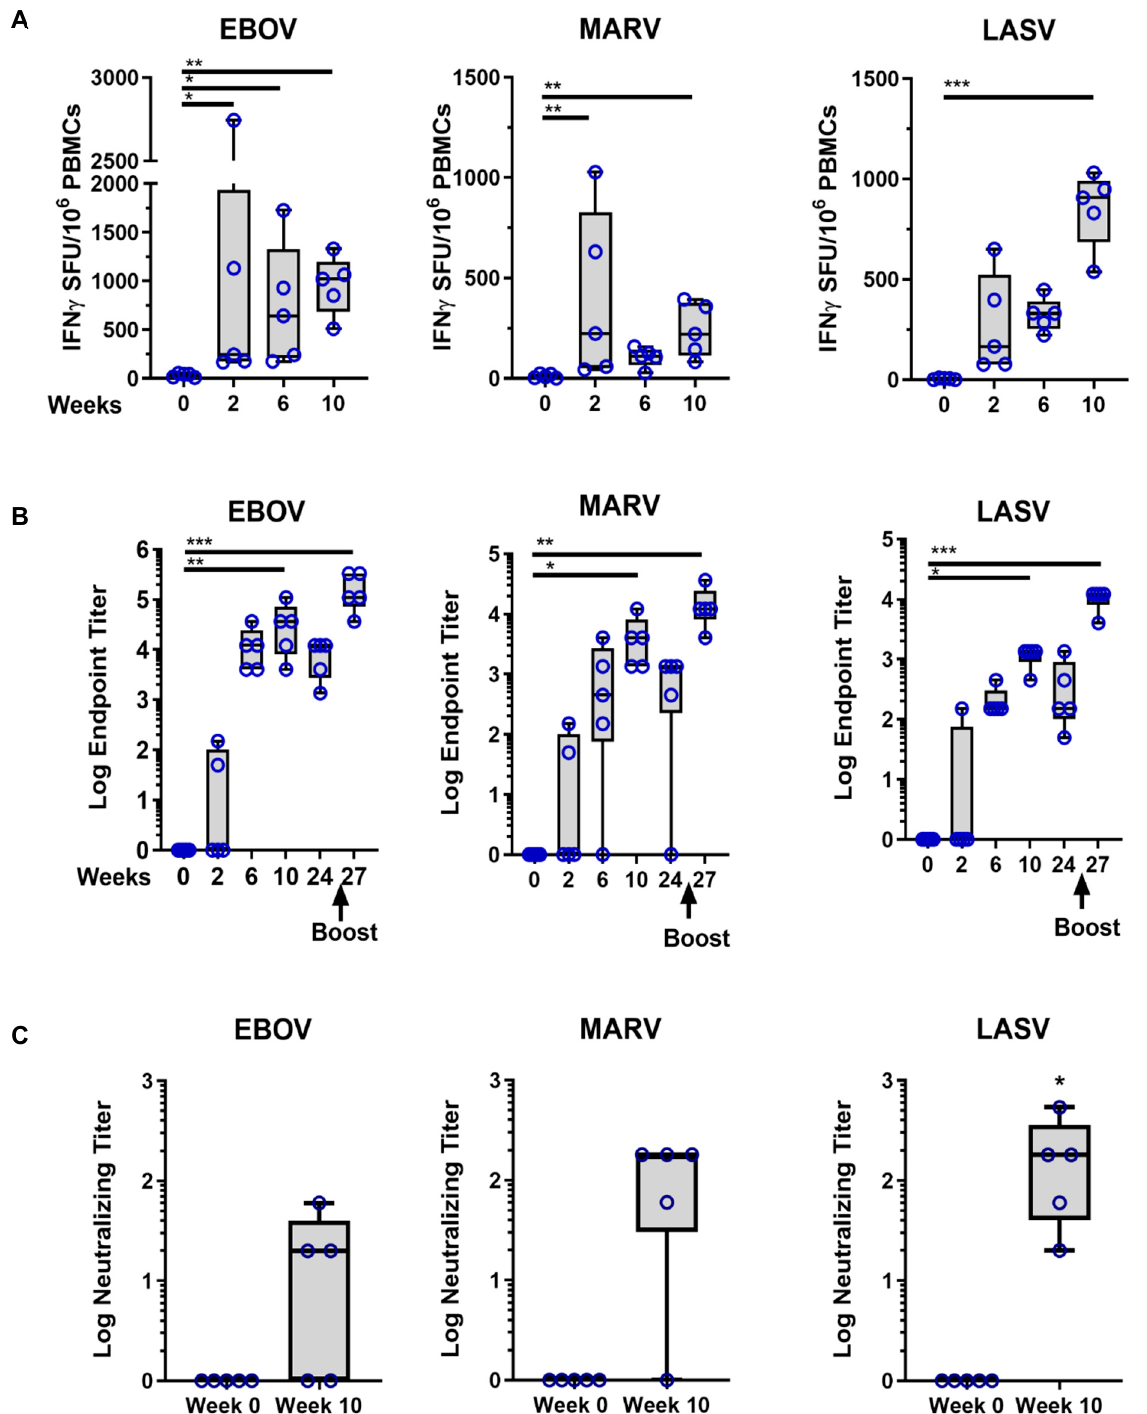
Figure 2. MHFV DNA Vaccine induces robust cellular and boostable humoral responses in Rhesus Macaques. Rhesus macaques ( n = 5) were immunized with pEBOV, pMARV, and pLASV plasmids delivered by ID-EP as individual formulations on weeks 0, 4, and 8 and received a booster immunization at week 25. ( A ) Specific T cell responses for individual NHPs at the indicated timepoints were measured by IFNy ELISpot following stimulation of PBMCs with EBOV, MARV, or LASV GP peptide pools. Data represents SFUs (spot forming units) per million PBMCs for individual NHPs. ( B ) Serum IgG EPTs for individual NHPs at the indicated timepoints were measured by binding ELISA to EBOV, MARV, or LASV GP proteins. ( C ) Serum neutralizing antibody titers for individual NHPs at the indicated timepoints were measured by pseudovirus neutralization assays for EBOV, MARV, and LASV GP expressing pseudoviruses. Asterisks indicate significant difference compared to Week 0 as described in the methods.